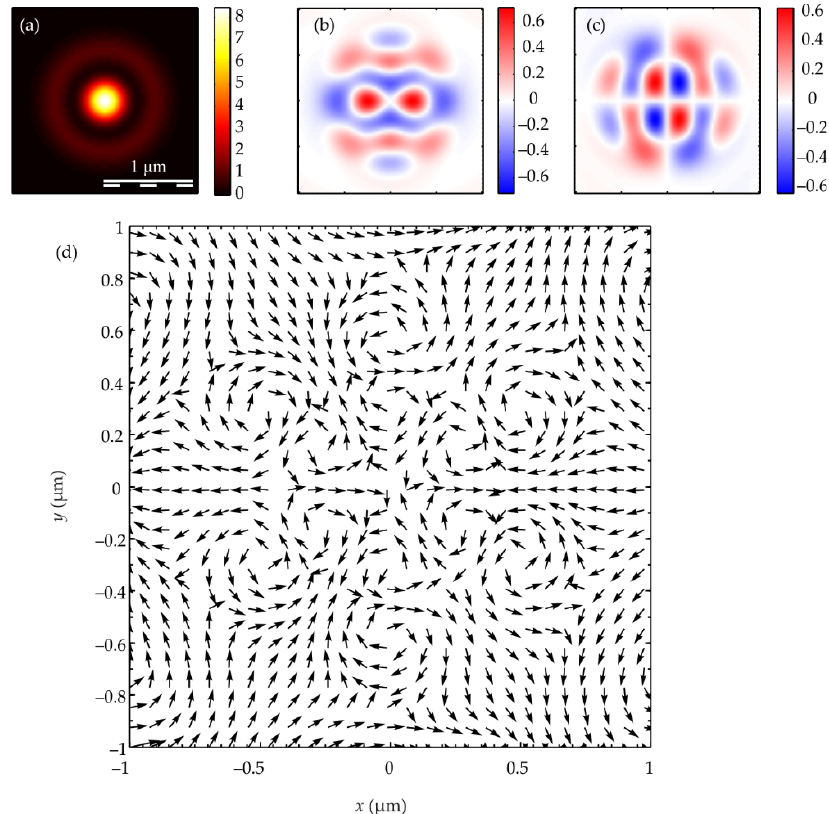
Figure 14. The Poynting vector components in the focus for m = 3 and a = 1: P z ( a ), P x ( b ), P y ( c ). The arrows show the direction of the transverse Poynting vector in the focus ( d ).